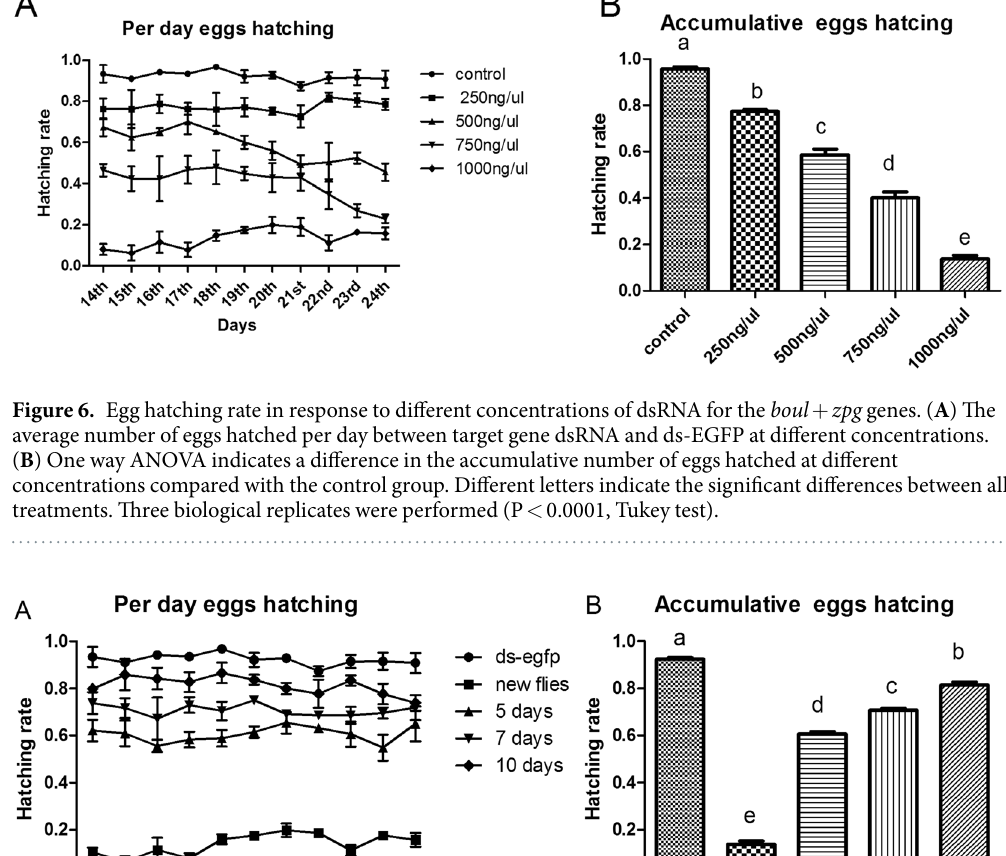
of the target pest 18, 19 . However, in the current study, all of target gene dsRNAs displayed a significant silencing effect and egg hatching rates were highly reduced, except with the two genes, fzo and gas8 . The lack of a signif- icant reduction in egg hatching rate compared with the control may be due to an inappropriate concentration or to the development of resistance to the dsRNA 20 . Another dsRNA feeding trial was conducted with Locusta migratoria in response to different doses, ranging from 0.1 µ g to 12 µ g and it did not show a significant effect on the target gene V-ATPase E ; however, a decline expression in mRNA was noted with the same genes at 18 µ g 21 . Inappropriate concentrations of dsRNA can also cause the upregulation of target gene expression. A similar para- dox of increased expression was noted in response to different concentrations of dsRNA 17, 22, 23 . It is very clear that proper nucleotide sequence, proper concentration and accurate modes of application are necessary to determine the exact silencing effects of dsRNA 20 . Our current results demonstrated an increase in the silencing effect and in male sterility in the target pest in response to target gene dsRNA (Fig. 5). Similar studies were conducted and revealed the effectiveness of boul gene dsRNA in male sterility against Bactrocera oleae . They revealed that males of the lead strain, OX3097D- Bol , 1) are strongly sexually competitive with wild olive flies, 2) display synchronous mating activity with wild females, and 3) induce appropriate refractoriness to wild female re-mating. Furthermore, they showed, through a large proof-of-principle experiment, that weekly releases of OX3097D- Bol males into stable populations of caged wild-type olive fly could cause rapid population collapse and eventual eradication 3 . Our results display greater efficiency and we found a significant reduction in spermatozoa (Fig. 8A). Our findings confirm that the selec- tion of target genes is very important. It could be argued that a mutation of the boul gene in Drosophila and